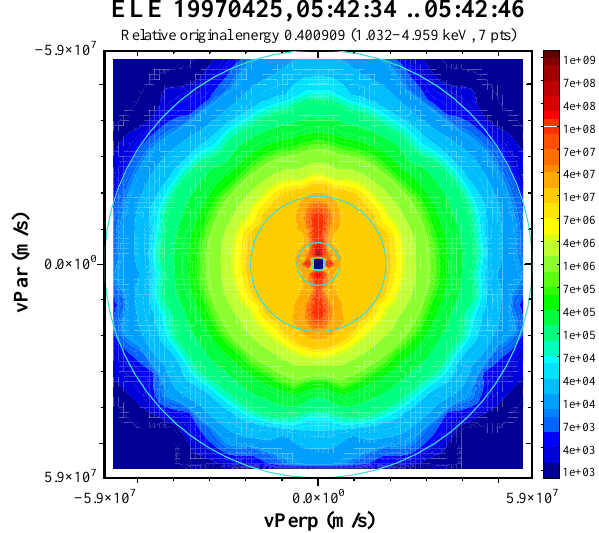
Fig. 9. HYDRA electron distribution function taken at 05:42:40 (central time) and integrated over 12s. Blue circles are drawn at ve- locities corresponding to energy 10keV, 1keV, 100eV and 10eV (the innermost one is quite small, the inside of which is shown as dark blue). Above 1keV the distribution is isotropic but be- tween 100–1000eV (and partly below 100eV also) it is strongly anisotropic.